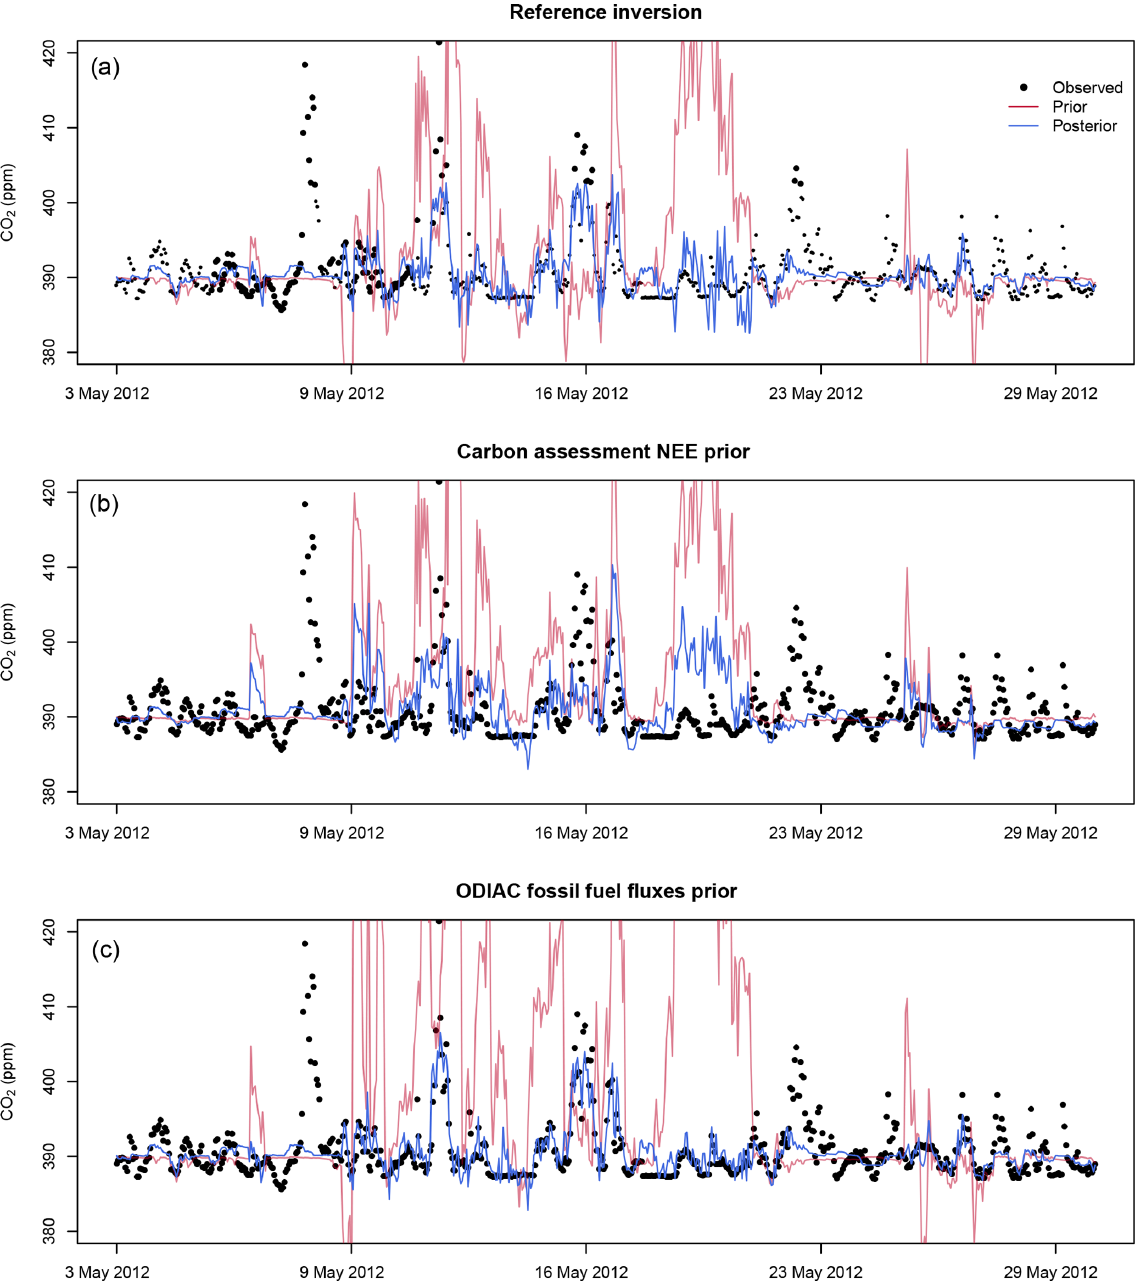
Figure 4. Prior and posterior modelled concentrations for the Hangklip site for the month of May 2012 for the reference inversion (a) , carbon assessment inversion (b) and ODIAC fossil fuel flux product inversion (c)